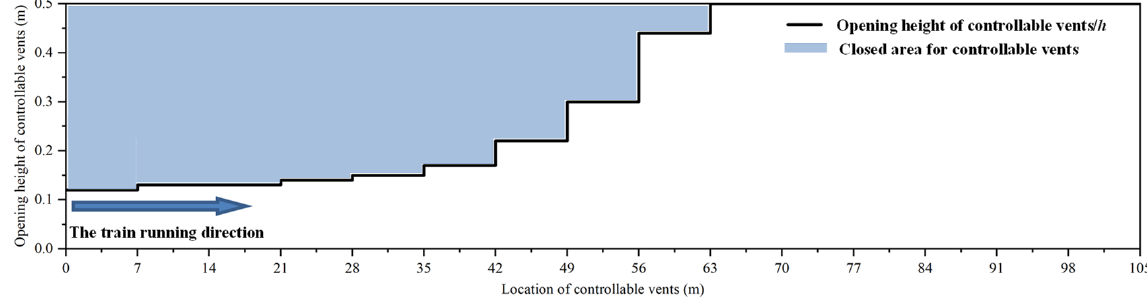
Figure 7. Distribution of the opening height of the controllable vents.